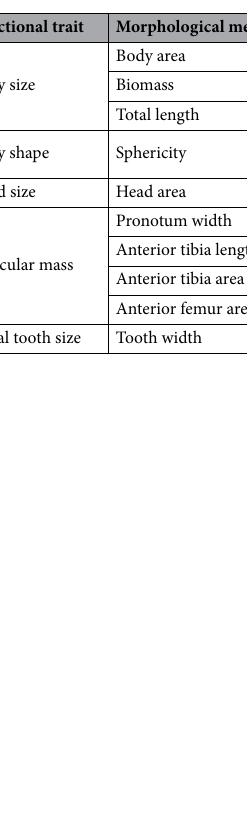
Functional trait Morphological measurement Ecological